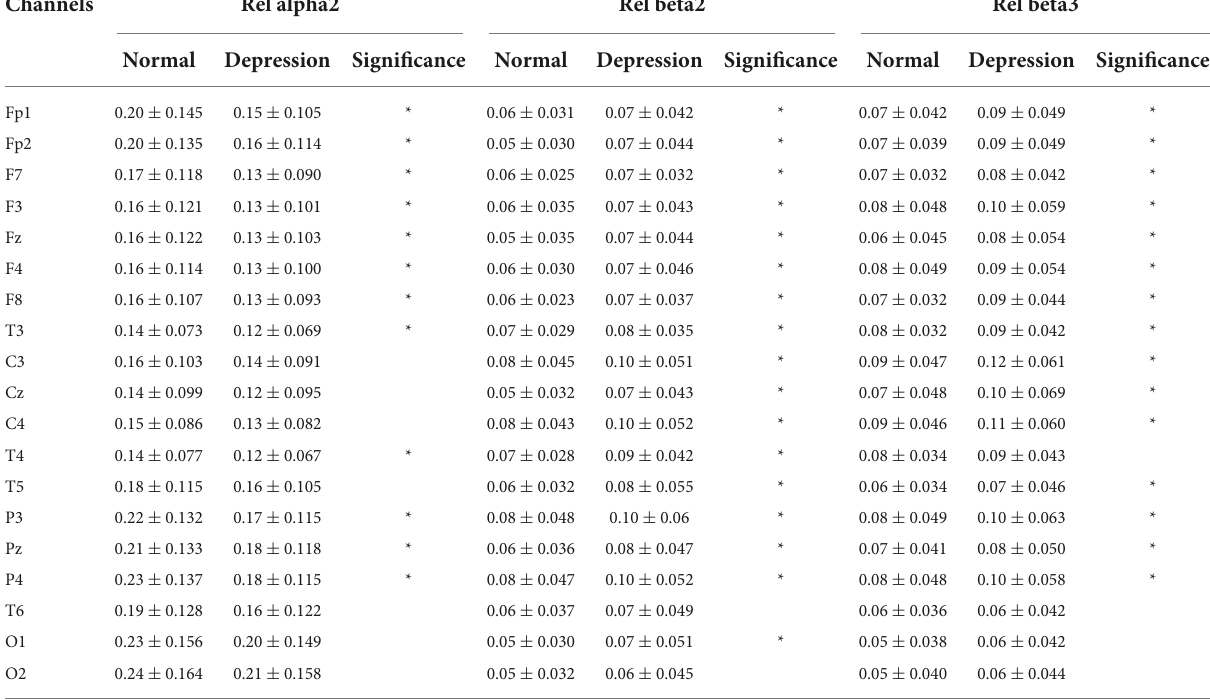
TABLE 2 Numerical values for each channel for relative alpha2, beta2, and beta3 power.